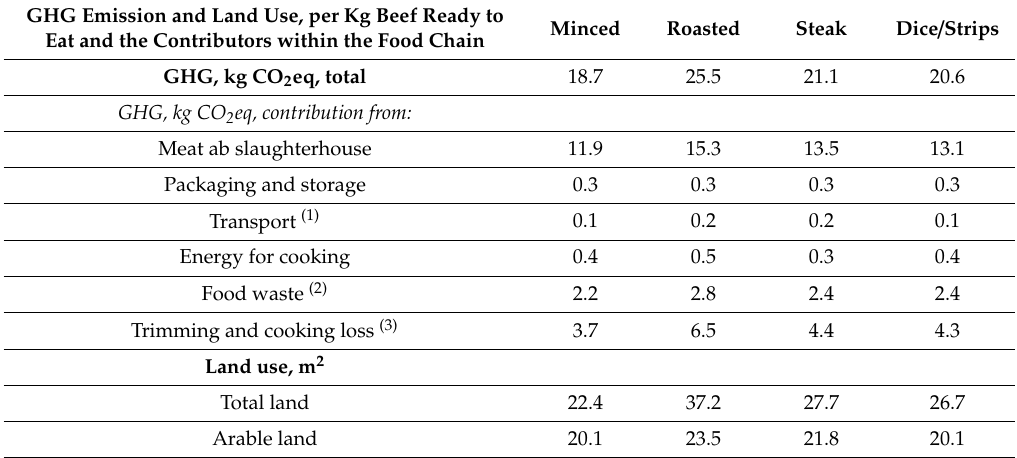
Table 2. Greenhouse gas (GHG) emissions and land use of beef products on the plate (per kg of beef ready to eat) depending on the type of beef, and contributiors from the food